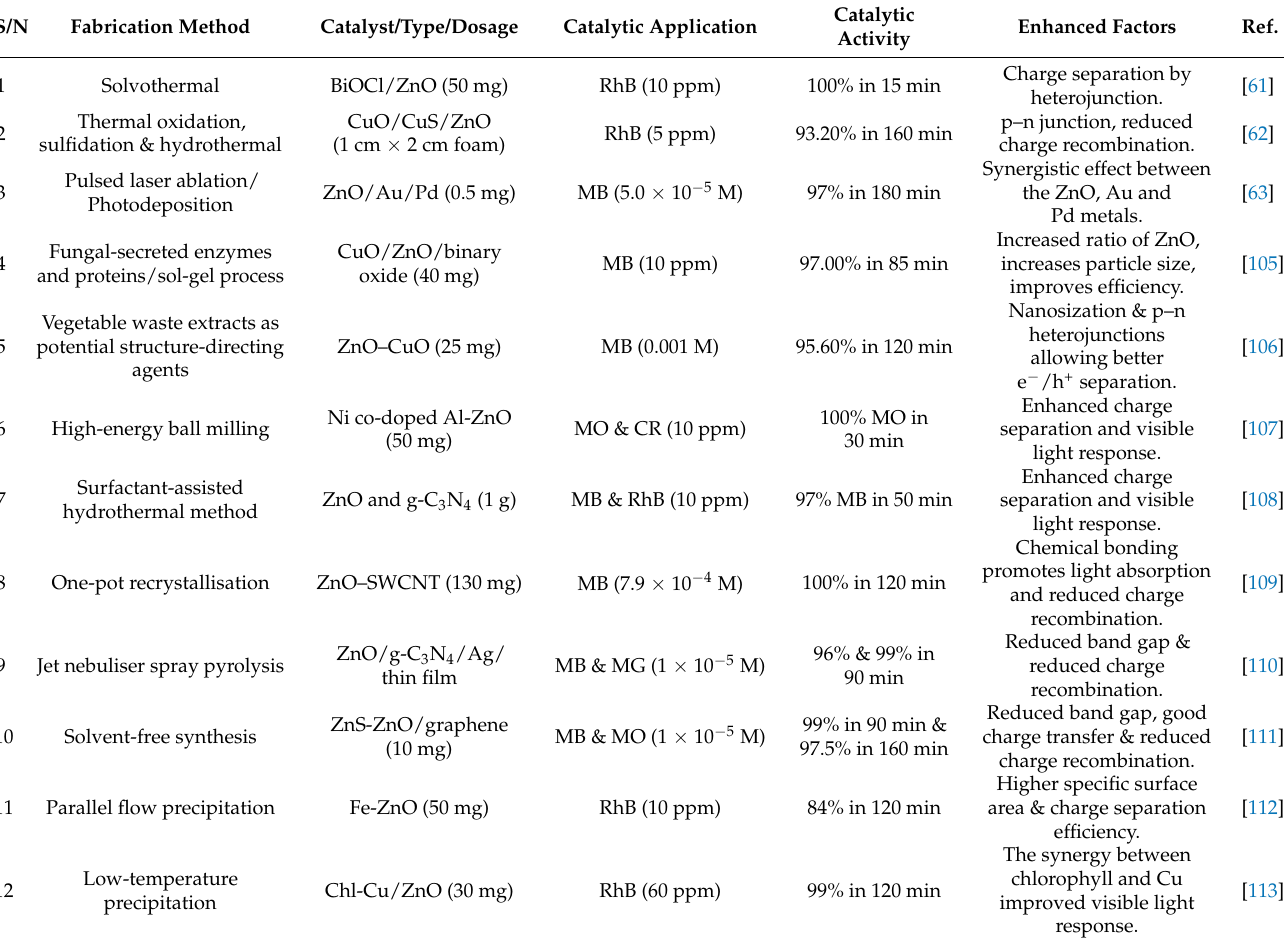
Table 5. Other methods of synthesis and applications of ZnO-based